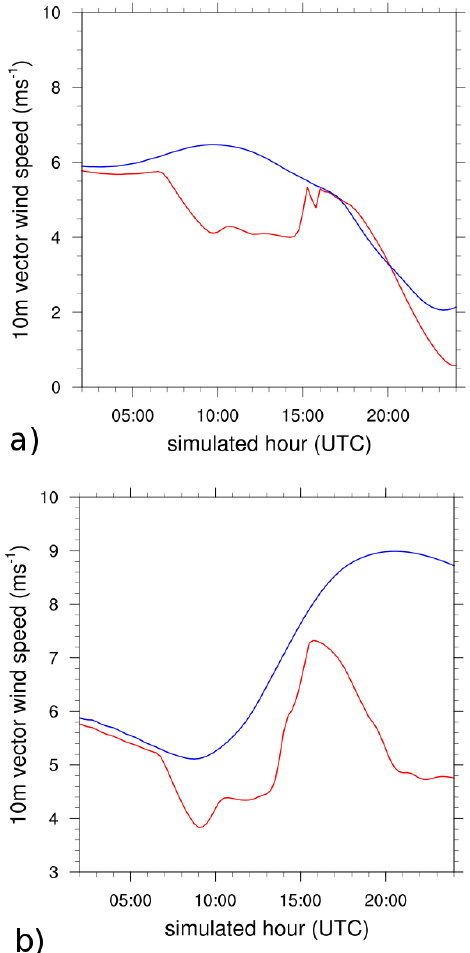
Fig. 17. The evolution of 10m vector wind speed for backdoor (a) and corkscrew (b) sea breezes at the coast (red) and 30km offshore (blue) in the single coast case. Shore-parallel gradient winds for both cases are of magnitude 6ms − 1 . The YSU PBL scheme was selected for both cases along with a SST of